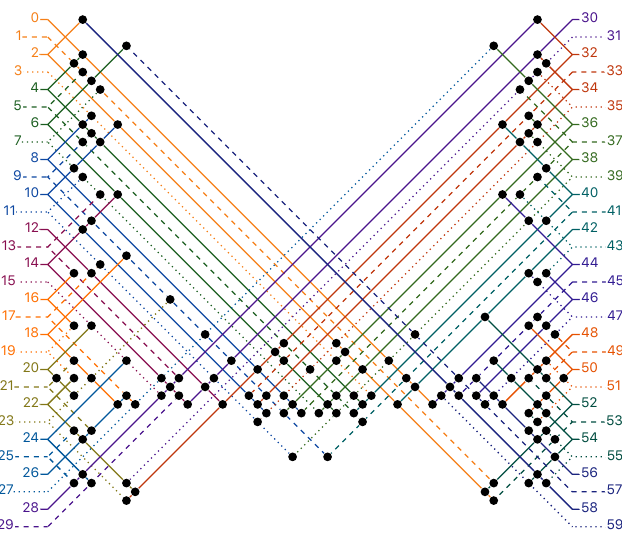
Figure 3. The rule of the Counter oritatami system : in this diagram, we have b b 1 iff there is a bullet ‚ at the intersection of one the two lines coming from b and from b 1 ; for instance, we have 4 8 but not 4